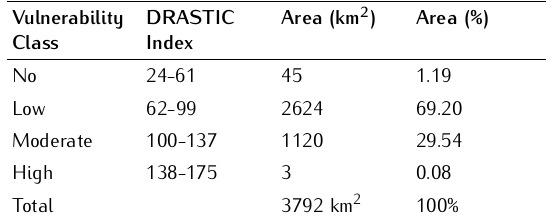
Table 6. DRASTIC index categories and areas vulnerable to groundwater pollution in the